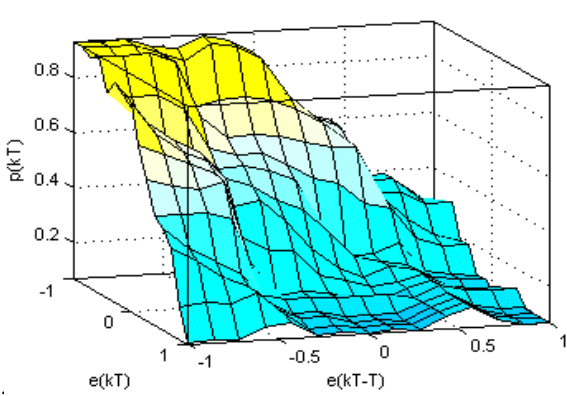
. Figure 15. Inference surfaces of FNNREM after training